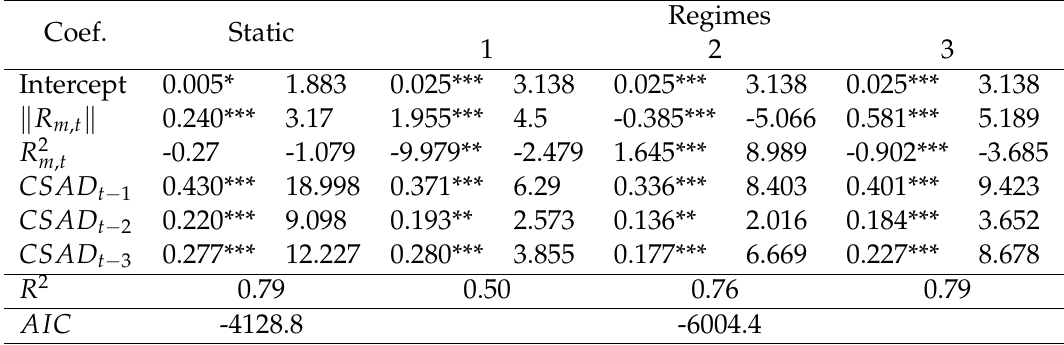
Table 2: Regression estimates of herding behavior on the full sample